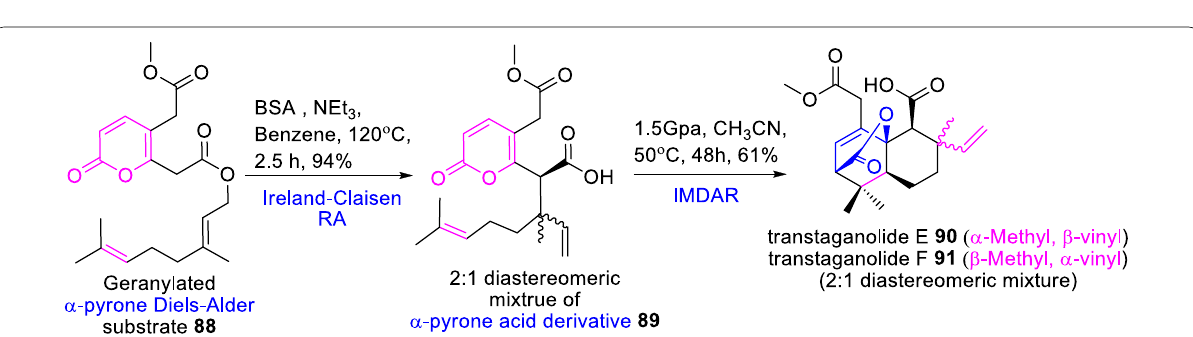
2:1 diastereomeric mixture of transtaganolides C ( 95 ) and D ( 96 ). Equally, the acrylated α-pyrone Diels–Alder substrate 92 under Ireland-Claisen condition provided a 1:2 mixture of C8 diastereomeric 97 in 65% yield. Fur- ther, the diastereomeric mixture was transformed into corresponding tricyclic silyl esters 98 , and then palla- dium driven [5 2] annulation caused the basiliolide + C ( 99 ) and epi -basiliolide C ( 100 ), respectively. Thus, the α-pyrone Diels–Alder template 92 and its electron- donating methoxy alkynyl group play a key role in the facile synthesis of the structurally complex transta - ganolides and